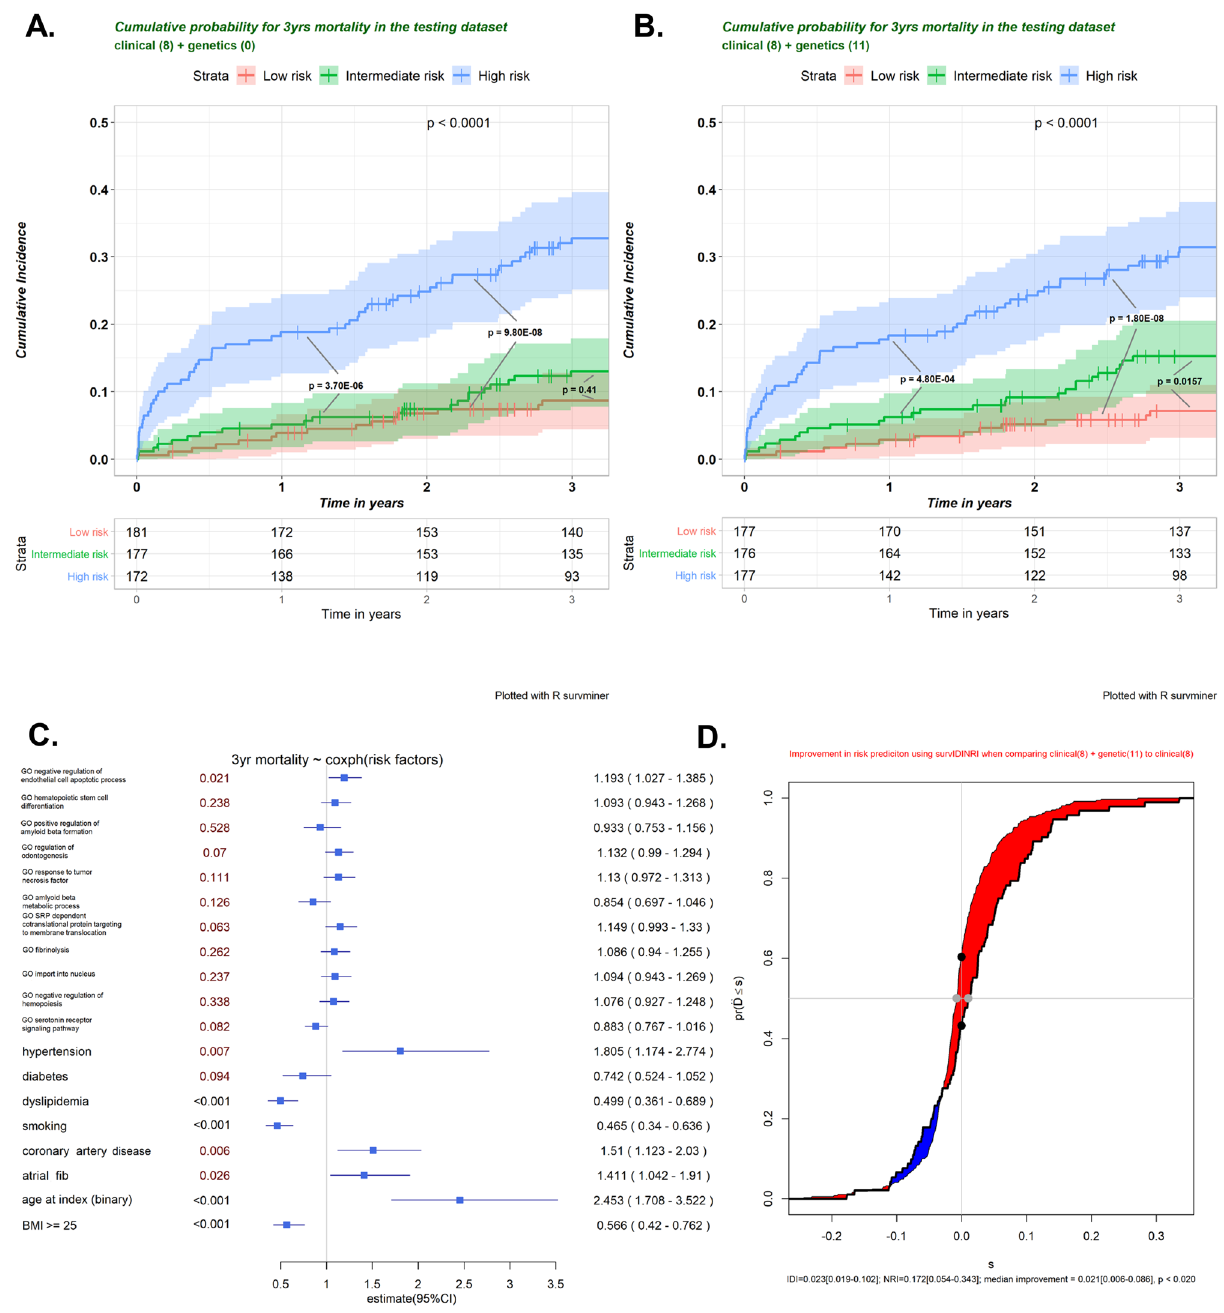
Figure 5. Kaplan–Meier analysis of post-IS cumulative probability for 3 year mortality in the testing sample. Vertical Bar represents right-censored patients. Assuming three risk categories with different survival probability in the testing sample, features included Z T β ) where Z T is a in the multivariate Cox proportional-hazards regression model were selected for calculation of the risk score ( β is a vector of estimate of effect size. P-value derived from Log-rank test provided a measure of how well vector of covariates and (cid:31) the model stratified risk sets. For the entire analysis, p < 0.05 was considered statistically significant. For all the post-hoc pairwise (cid:31) tests, p-values were adjusted by Benjamin-Hochberg procedure. The number of patients at risk was listed in the table. We used candidate features with a p value < 0.05 from the univariate Cox regression model as an example for feature selection. We compared Kaplan–Meier curves developed from the base model ( A ) to the integrated model ( B ) with an additional 11 pathway-specific PRSs in the testing sample after the LASSO-based feature selection using the training sample ( C ). The forest plot demonstrated the effect size (HR) for the integrated multivariate Cox regression model in the training sample; ( D ). We calculated continuous Net Reclassification Index (NRI), Integrated Discrimination Improvement Index (IDI), and median improvement by R ‘survIDINRI’ package, as metrics to determine the improvement in prediction when comparing integrated model after additional features selected to the corresponding base model. The additional value of pathway-specific PRS is assessed by the paired difference of risk scores. The empirical distribution D t 0 function of the paired difference ( ) between the risk scores (on the probability scale) estimated at = 3 years using models with and without the inclusion of pathways-specific PRSs. The added value of these PRSs is proportional to the area of the shared region. The (cid:31) vertical difference at s = 0 (between the two black dots, where s scales the region between − 1 and + 1) is NRI (> 0), and the horizontal D difference (between the two gray dots) equals the median risk-score difference. Y-axis, cumulative probability; X-axis, s = , the difference between two model risk (cid:31)